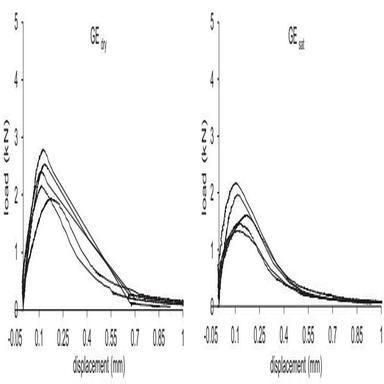
Flexural load–displacement diagrams of tested GE specimens: dry mass (left) and saturated (right) conditions.